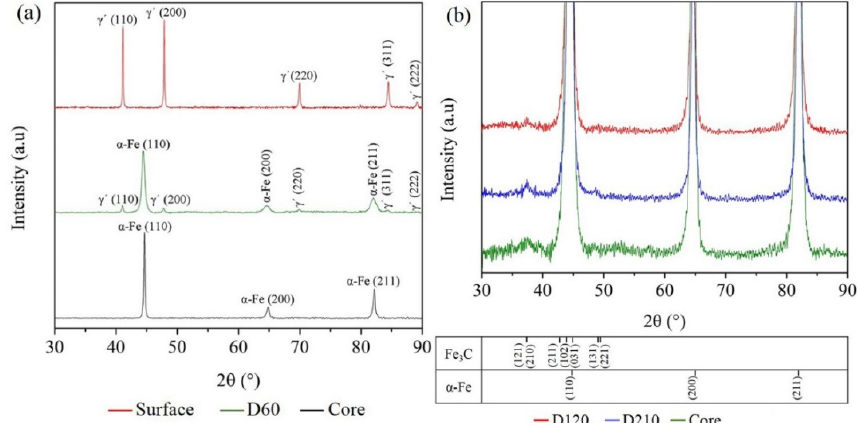
Figure 3. ( a ) XRD patterns taken from the surface, 60 µm from surface, and in the core of the nitrided sample. Only one series of diffraction peaks can be seen from the surface data, corresponding to the sample. Only one series of di ff raction peaks can be seen from the surface data, corresponding to γ ´-Fe 4 N iron nitride phase. The diffraction patterns of the core correspond to α -Fe (tempered the γ ´-Fe 4 N iron nitride phase. The di ff raction patterns of the core correspond to α -Fe martensite). At the depth of about 60 µm below the surface, diffraction peaks both from γ ´-Fe 4 N and α -Fe can be identified. ( b ) Magnification of XRD patterns with range of the lower intensity of 120 µm, 210 µm, and the core center. They are composed of α -Fe and Fe 3 C.